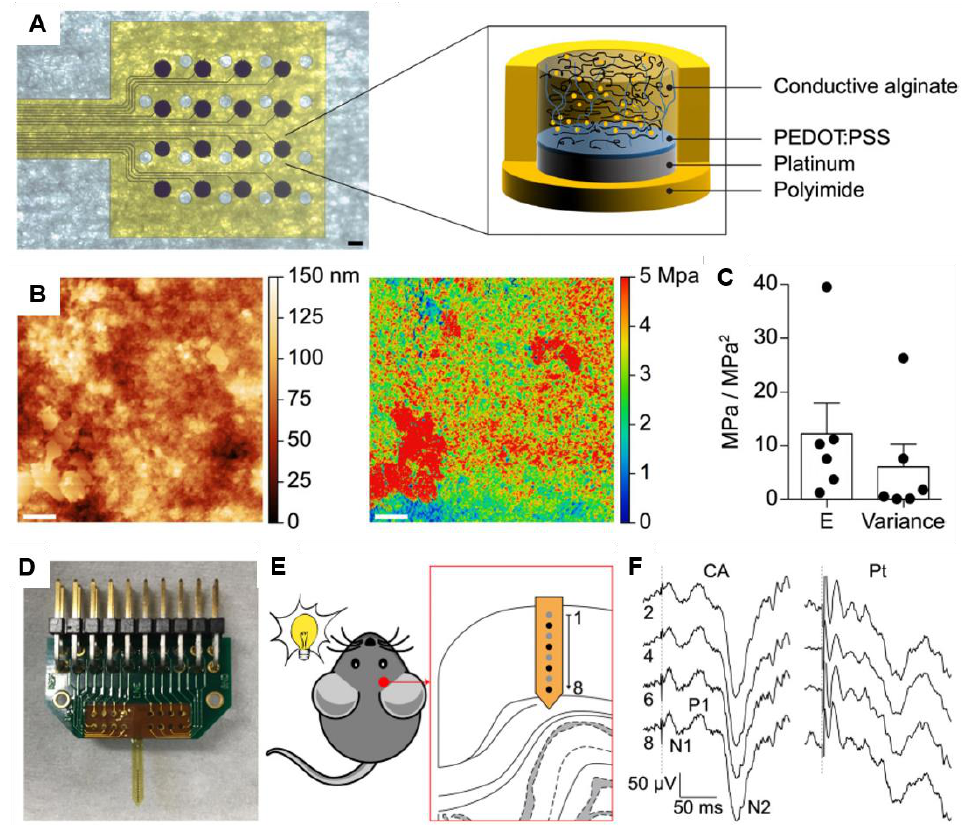
Figure 10. Pictures of the g-MEA 400 µm-diameter electrodes (the scale bar is 400 µm) and scheme of the soft CA-based electrode structure ( A ). AFM topography map of a 3 µm × 3 µm surface area of the alginate modified electrodes (left) and the corresponding elastic modulus surface map (right). The scale bar is 400 nm ( B ). Quantification of the mean (± SEM) stiffness and variance ( n = 6 electrodes, 1 map per electrode) ( C ). Validation in vivo of the modified electrodes ( D – F ). Picture of a penetrating MEA with CA electrodes ( D ). Experiment sketch ( E ). Representative single-sweep recordings from 4 (out of 8) PEDOT-alginate-based electrodes ( F ). Adapted under the terms of the CC-BY-4.0 license [101]. Copyright 2018, The author(s).